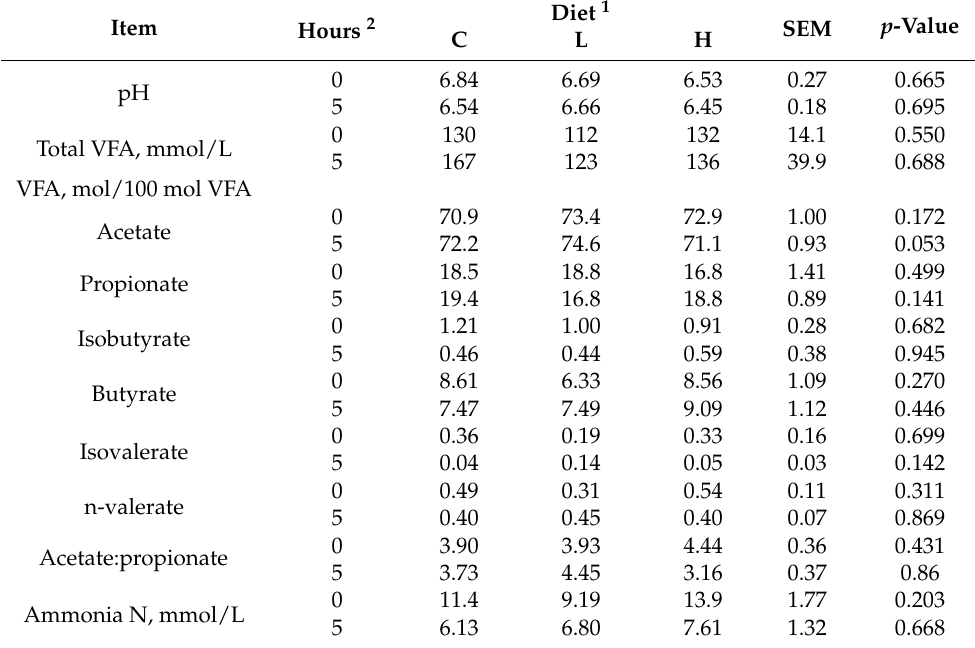
Table 4. Rumen fermentation parameters of the goats fed the experimental diets, sampling the rumen fluid just before the morning meal and 5 h after.